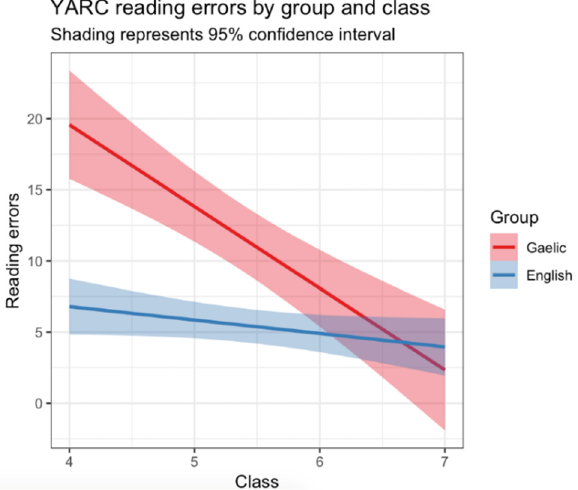
Figure 5. YARC reading errors by group (Gaelic and English), by class.